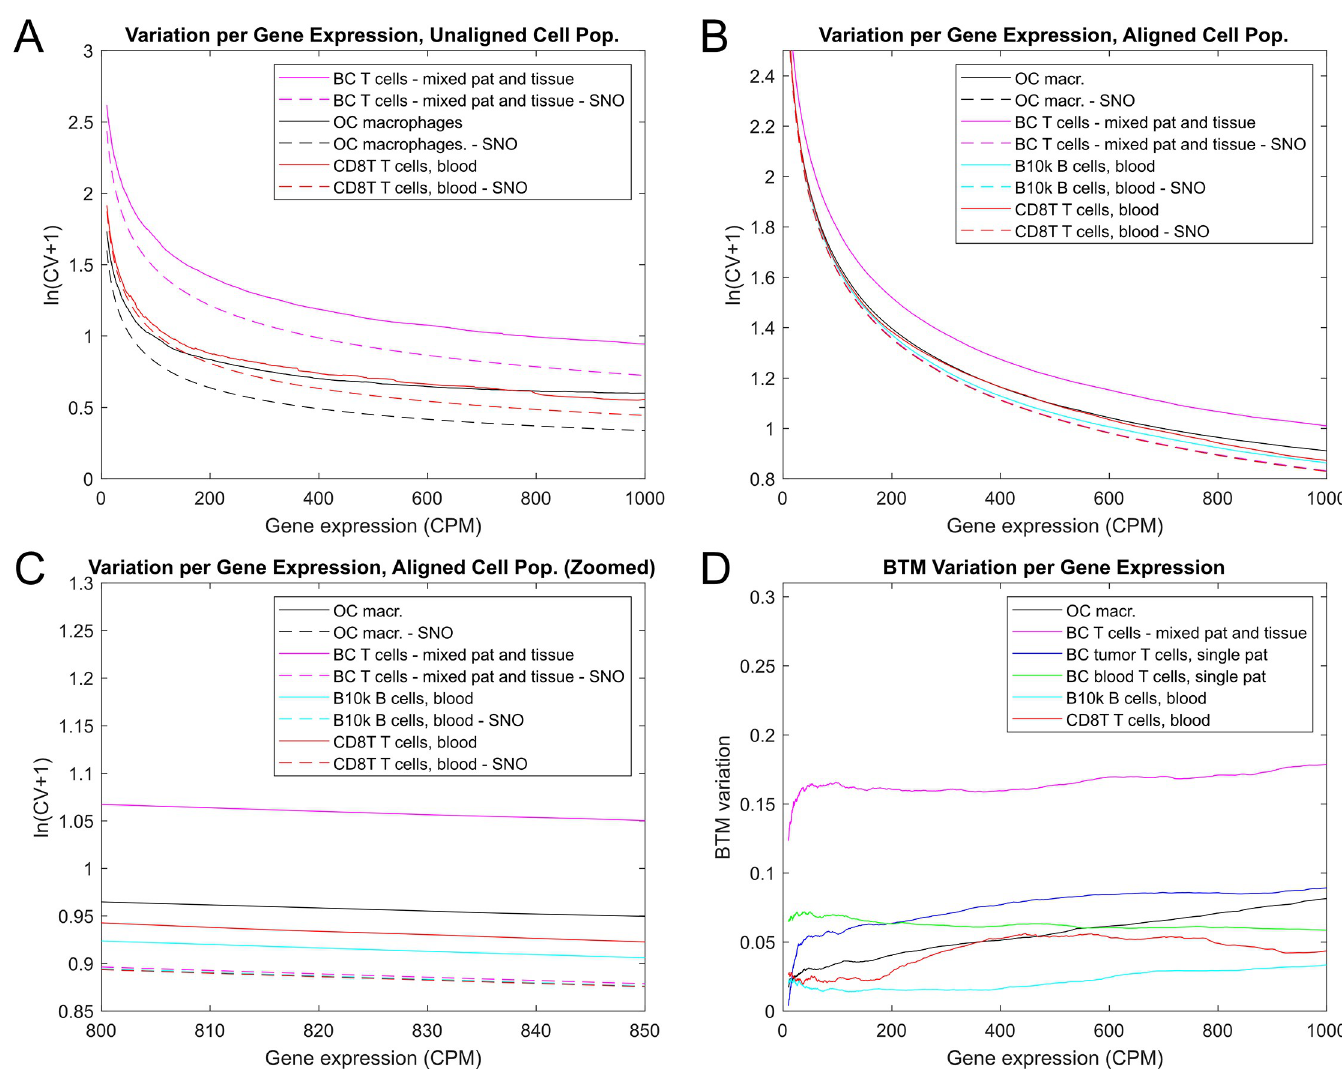
Fig 5. Investigation of BTM variation. A. Variation as a function of gene expression for 3 cell populations and their SNO counterparts. The cell populations have not been aligned. B, C. Variation as a function of gene expression for 4 aligned cell populations and their SNO counterparts. All SNO cell populations now have virtually identical variation, meaning that any difference in total variation between aligned cell populations corresponds to the difference in BTM variation. D. The difference between the variation for the observed and SNO cell population as a function of gene expression. These curves represent the BTM